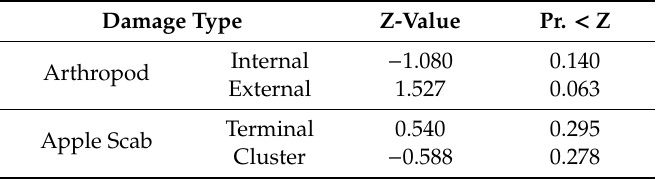
Figure 8. Mean percent incidence of arthropod damage on fruit. Mean incidence shown from the airblast and SSCDS treated plots, with a comparison check from a nearby untreated orchard (Check not included in statistical analysis). Error bars indicate standard error of the proportion. Table 6. Results of four exact Wilcoxon rank sum tests for each category of damage. ‘Internal’ refers to internally feeding lepidopteran damage from stings or entries, and ‘external’ refers to damage from Plum Curculio and Pentatomidae. ‘Terminal’ and ‘cluster’ refer to apple scab damage on those portions of the plant. Significance was determined at the alpha = 0.05 level.